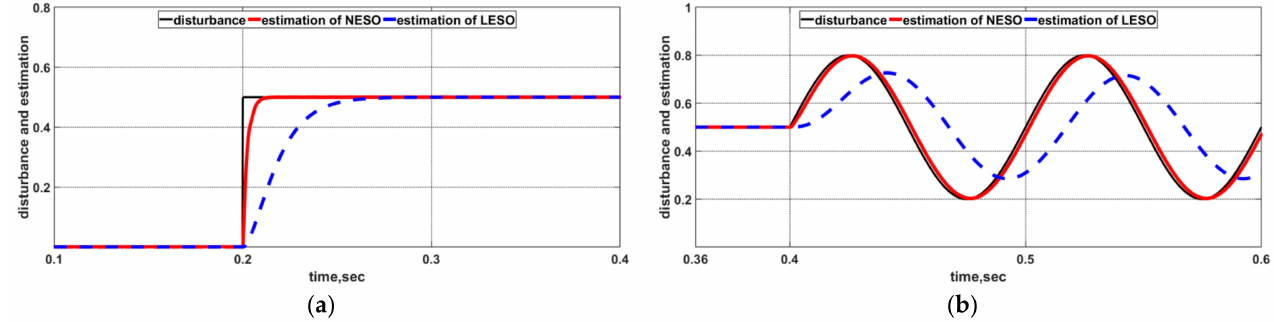
Figure 5. Performance comparison of two observers under the disturbance of ( a ) T L = 0.5 N and ( b ) T L = 0.5 N + 0.3sin ( 20 π t ) N